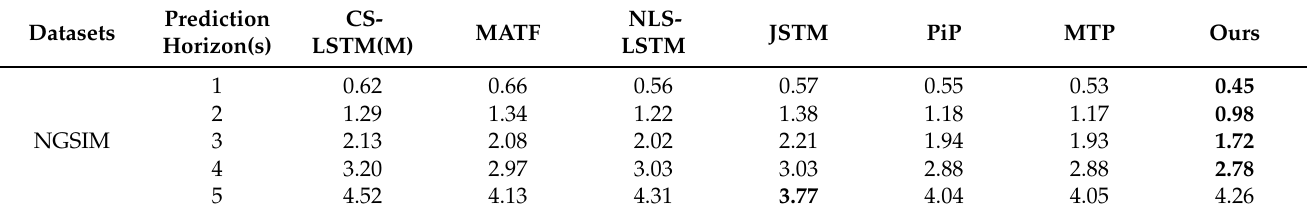
Table 2. Comparison of RMSE at each prediction horizon evaluated on NGSIM datasets. Bolded numbers indicate best results.